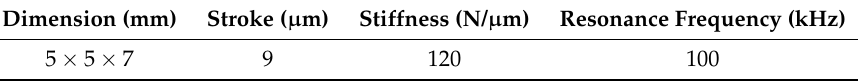
Figure 2. Schematic illustration of the motor setup. ( a ) Mechanical structure illustration of the motor; ( b ) Compositions of the pusher part. Table 1. Data sheet of the piezoelectric stack used in the